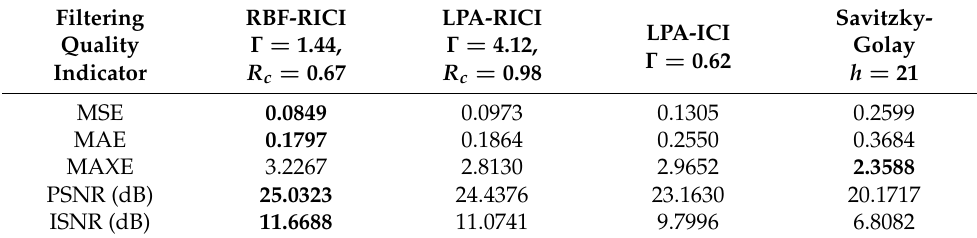
Table 2. Blocks signal (SNR = 7 dB)—Filtering results.